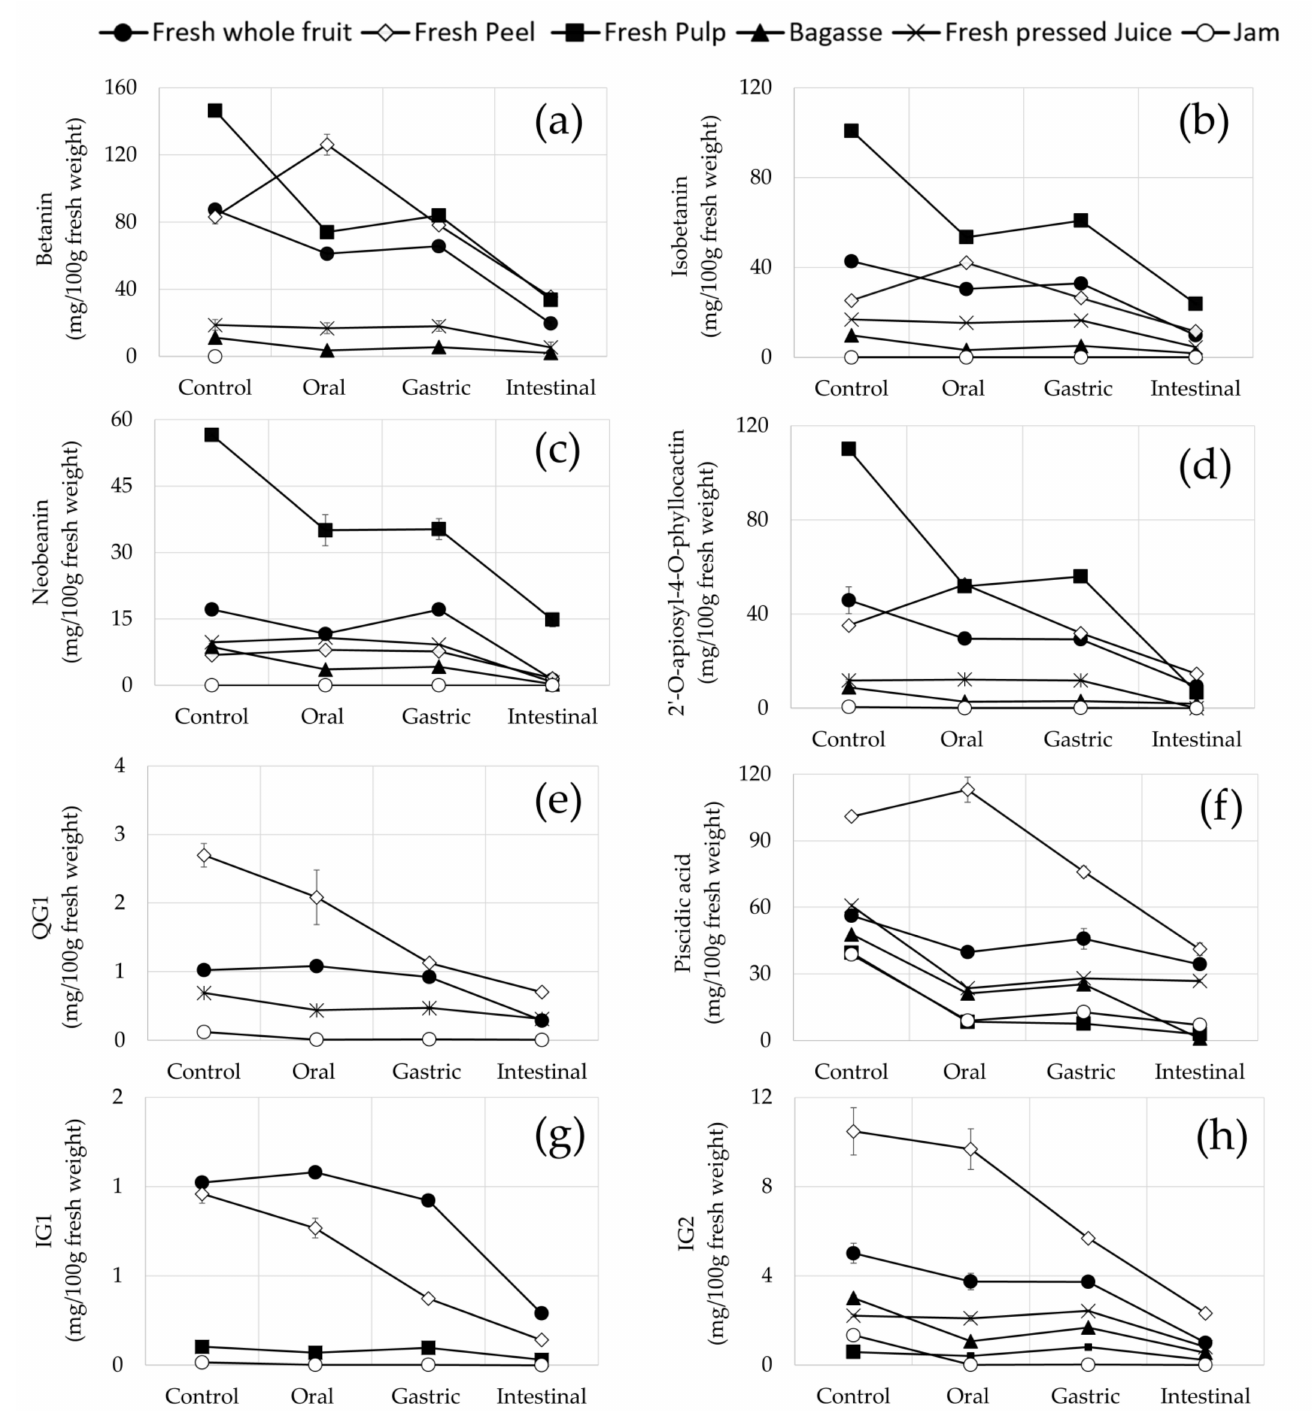
Figure 6. Bioactive content (mg/100 g fresh weight) in Opuntia stricta var. Dillenii fruit tissues (peel, pulp, and whole fruit), jam production products (intermediate juice and jam), and by-product (bagasse) during in vitro gastrointestinal static digestion. ( a ) Betanin, ( b ) isobetanin, ( c ) neobentanin, ( d ) 2 (cid:48) -O-apiosyl-4-O-phyllocactin, ( e ) piscidic acid, ( f ) quercetin glycoside (QG1)—quercetin hexosyl pentosyl rhamnoside, ( g ) isorhamnetin glucoxyl-rhamnosyl-rhamnoside (IG1), and ( h ) isorhamnetin glucoxyl-rhamnosyl-pentoside